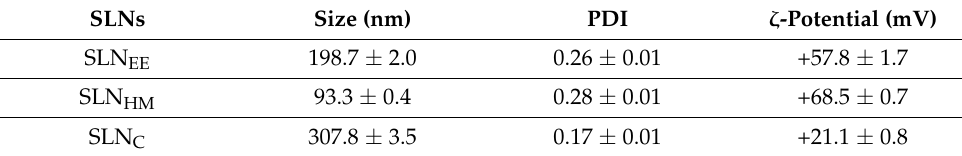
Table 2. Physical characterization of solid lipid nanoparticles